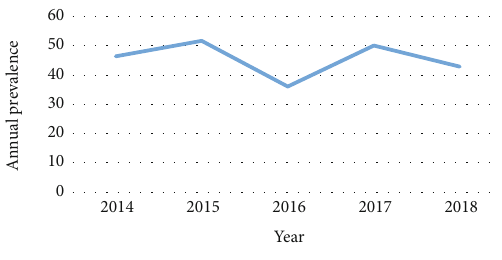
Figure 2: Trend of intestinal parasite prevalence among students at University of Gondar student ’ s clinic, 2014 –